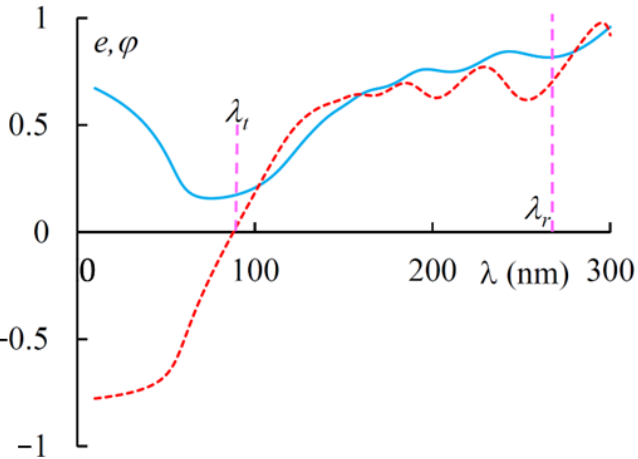
Figure 7. The spectra of ellipticity e (solid line) and polarization.